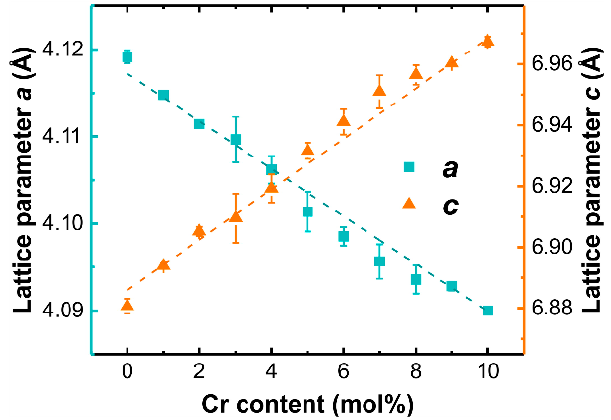
Figure 3. LaOCl lattice parameter dependence on the level of Cr content.